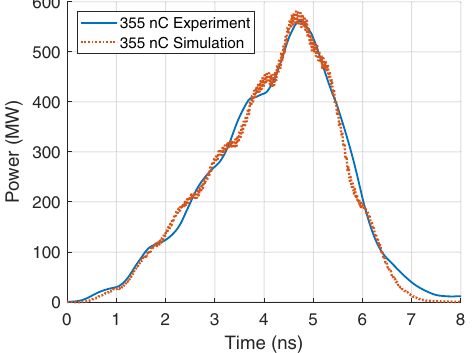
FIG. 23. Experimental plot of typical 350 MW experimental trace in solid blue, from a 224 nC 8-bunch train. The red dashed simulation assumes an 224 nC eight-bunch train that centered on-axis. The yellow dot-dashed simulation assumes the same bunch train but offset by 0.05 mm per bunch and tilted by 0.025° per Fig. 23. The output pulse expected from a 224 nC train of eight bunches centered on axis is represented by the dashed red simulation plot. It can be seen that the seventh and eighth bunches do not contribute substantially to the rf output in the experiment. The yellow dot-dashed line in Fig. 23, which closely matches the experimental trace, assumes an eight-bunch train of total charge 224 nC with the first bunch on axis and subsequent bunches offset by 0 . 05 mm = bunch and tilted by 0.025°/bunch.